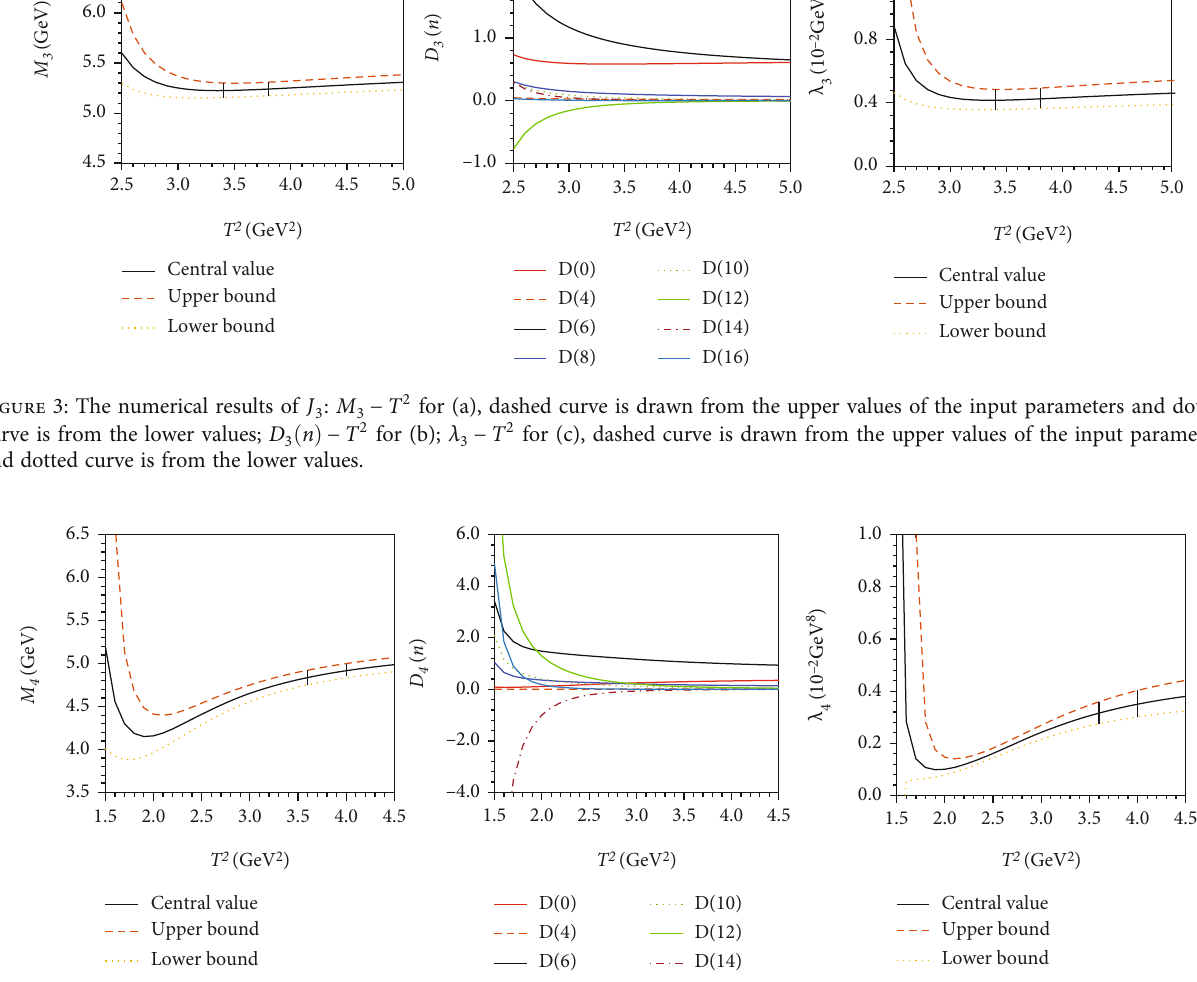
− T 2 for (a), dashed curve is drawn from the upper values of the input parameters and dotted : M 4 4 ð n Þ − T 2 for (b); λ − T 2 for (c), dashed curve is drawn from the upper values of the input parameters 4 4